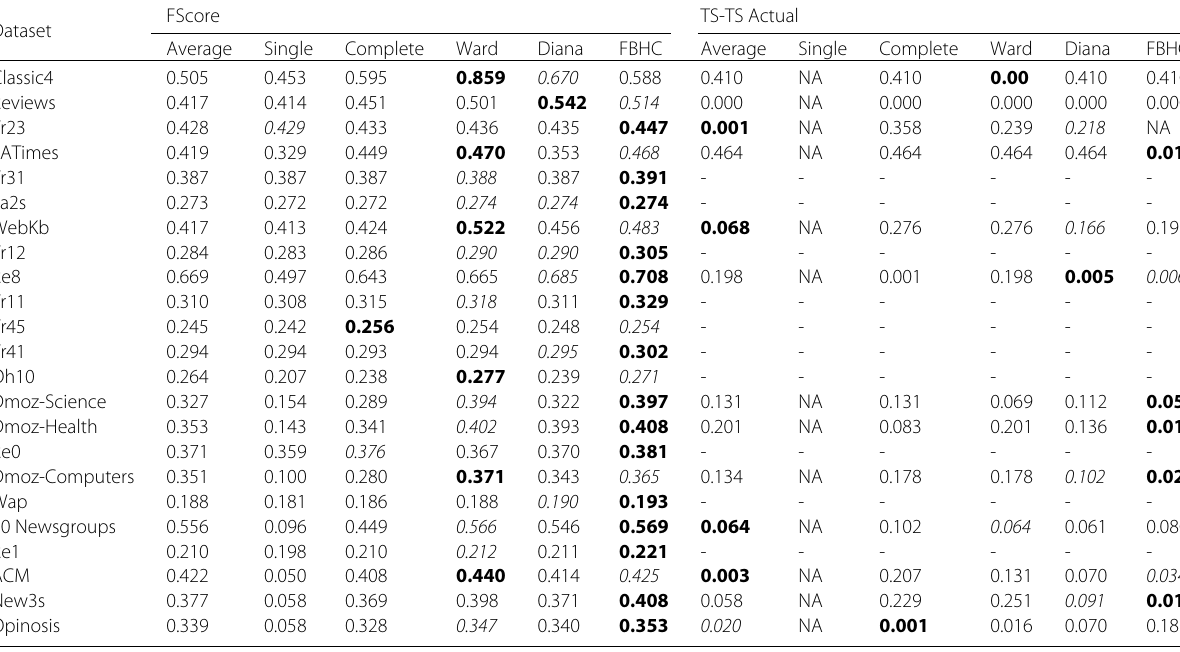
Table 2 The FScores and the TS values for the different datasets using various hierarchical clustering methods Dataset